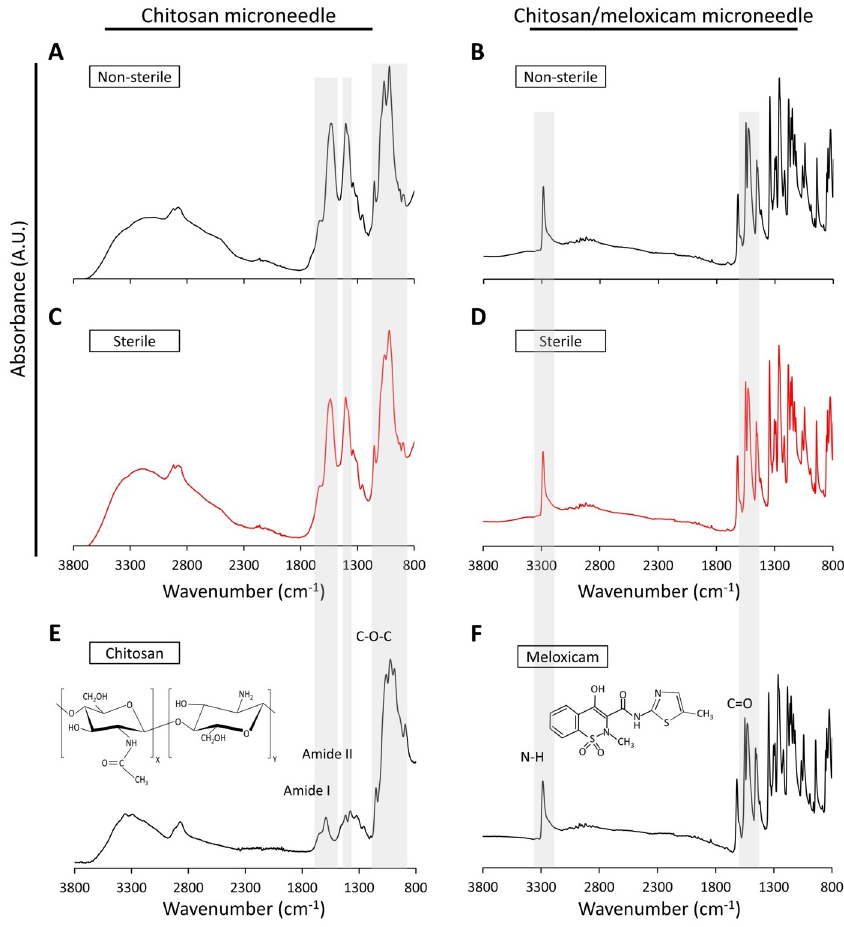
Fig 4. FTIR spectra confirmed that microneedle patches with and without drug preserve the chemical composition of chitosan polymer and meloxicam drug after the sterilization process using ethylene oxide gas. FTIR spectrums of non-sterile and sterile patches. Chitosan microneedle patch. A) Non-sterile, B) Sterile. Chitosan microneedle patch with high concentration of meloxicam. C) Non-sterile, D) Sterile. Spectrums of pure polymer and drug. E) Chitosan, F)